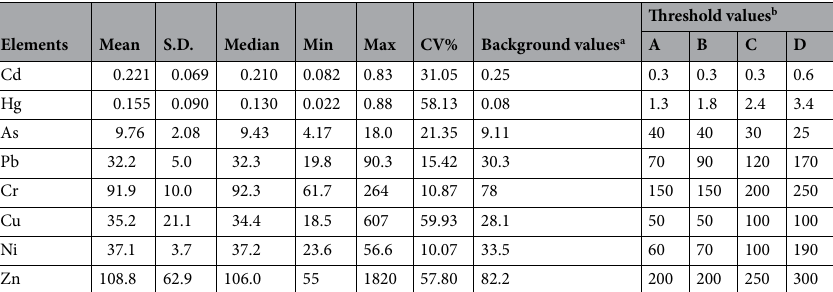
Table 2. Statistical summary of HMs concentrations (mg/kg) in soil. a The background values of soil metal(loid)s for Chengdu 29 . b The risk screening values for soil contamination (GB 15618-2018) (MEEC, 2018), A: pH ≤ 5.5, B: 5.5 < pH ≤ 6.5, C: 6.5 < pH ≤ 7.5, D: pH >